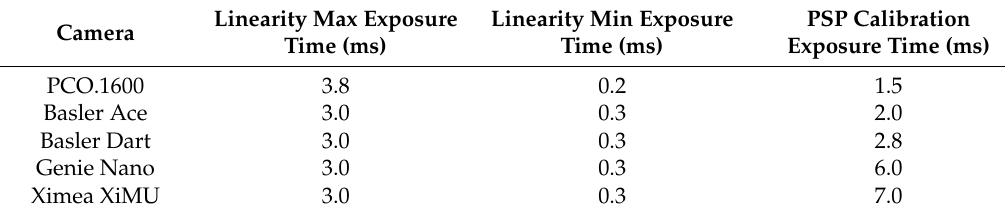
Table 2. Exposure times for different